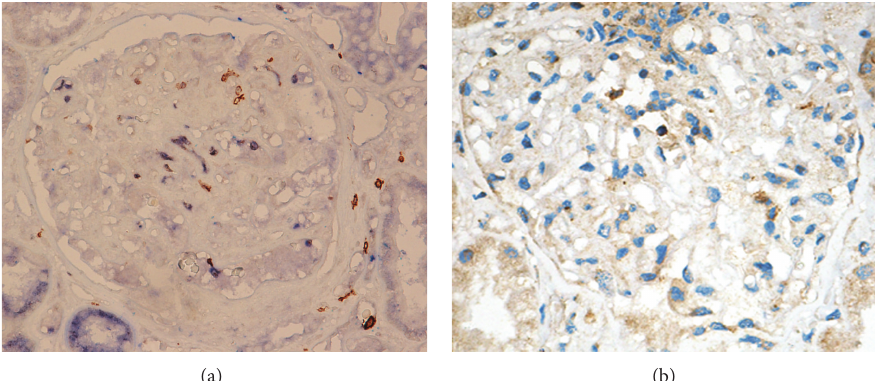
Figure 1: Immunohistological analysis of intraglomerular T-bet and GATA3. Positive staining is labeled in brown color. (a) Intraglomerular